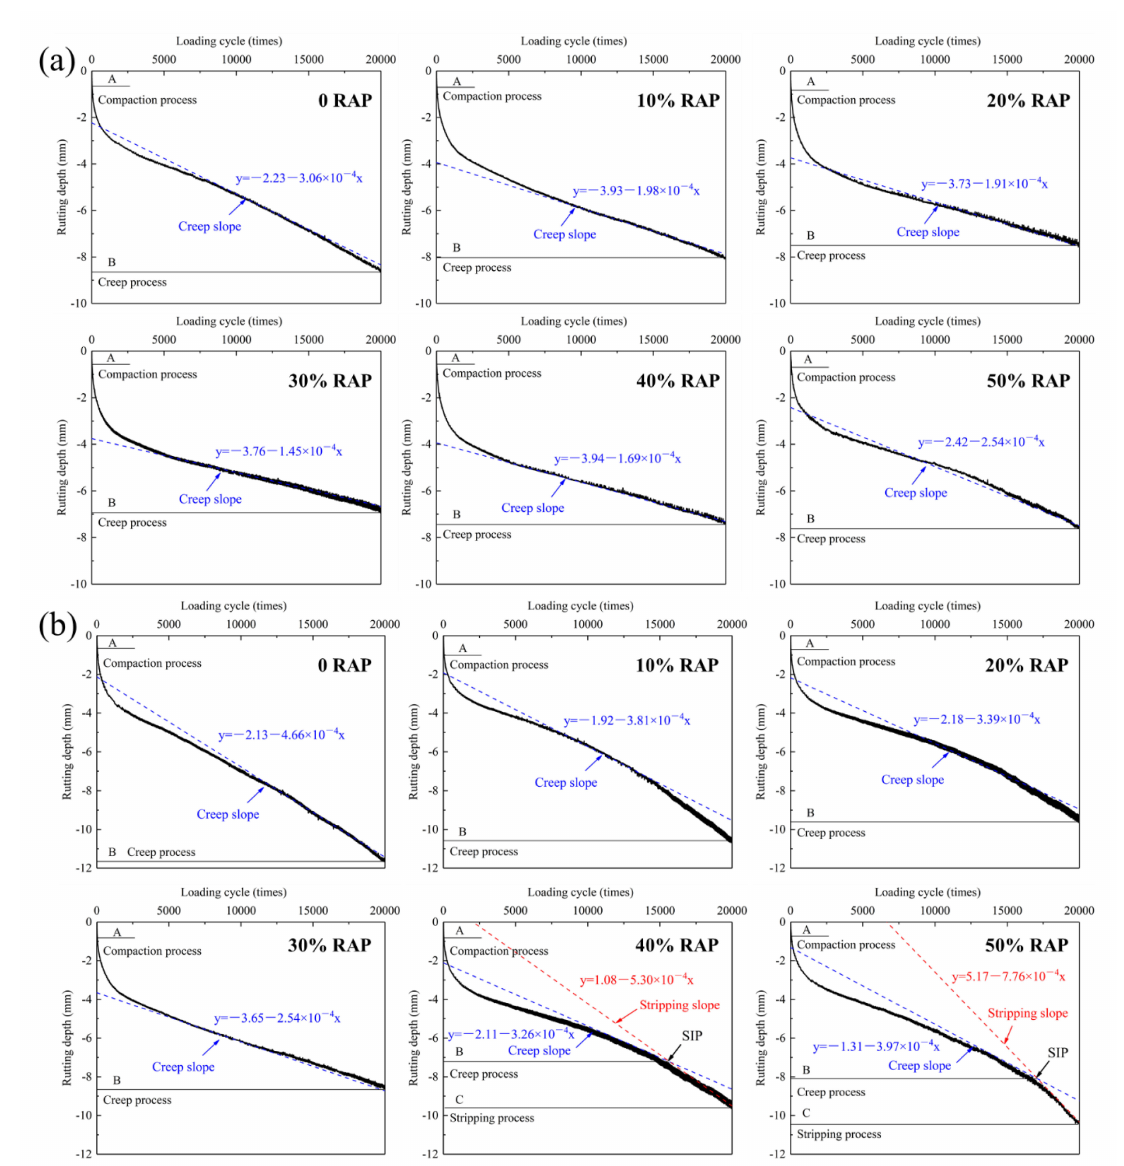
Figure 10. Deformation development of RAM with the increasing loading cycle: ( a ) steel slag; ( b )